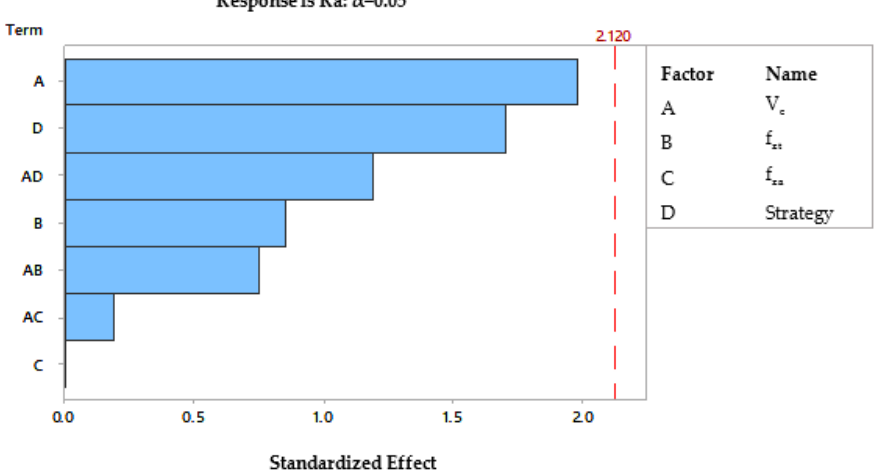
Figure 15. Pareto chart of the standardized e ff ects for burr height.